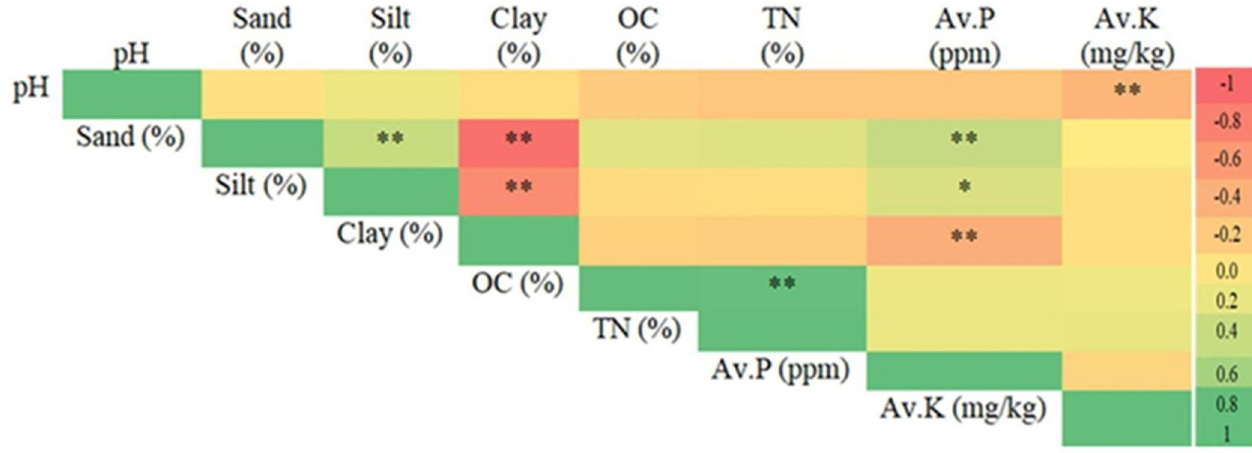
Fig 5. Pearson’s correlation matrix among soil variables in the 0–30 cm soil layer. Correlation values are colour-coded. OC, organic carbon; TN, total nitrogen; av. P, available phosphorus; av. K, available potassium. Asterisks indicate significant differences: � P < 0.05 and �� P < 0.01.